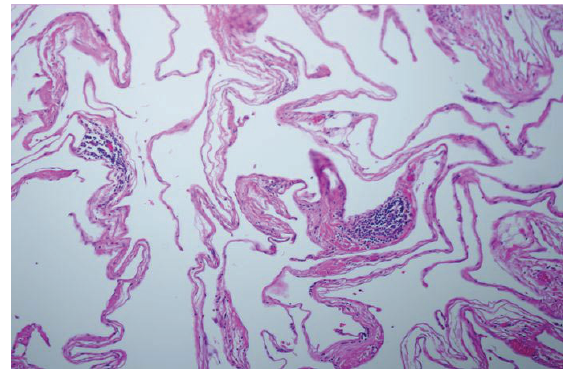
Figure 3. HE - Hematoxylin and eosin-stained histological section of multilocular cystic